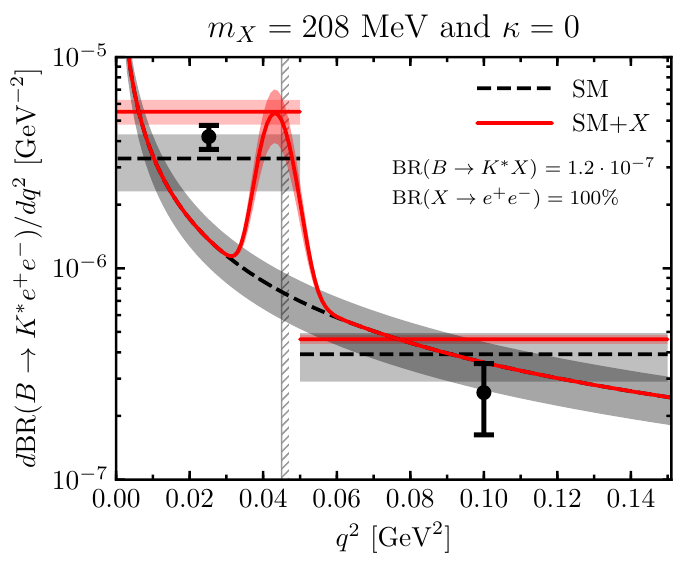
Figure 3 . The di(cid:11)erential branching ratio d BR( B ! K (cid:3) e + e (cid:0) ) =dq 2 in the SM (dashed black) and in the presence of a resonance with the best-(cid:12)t values for its mass and BR( B ! K (cid:3) X ) (solid red). We also show the binned predictions together with the LHCb measurements from ref. [19]. The vertical line indicates the lower boundary of the low- q 2 bin in the R K (cid:3) measurement. key prediction is therefore a peak in the di(cid:11)erential B ! K (cid:3) e + e (cid:0) rate at a q 2 close to the di-muon threshold. For a resonance that decays only to electrons ( y = 0 ; (cid:20) = 0), the 68 : 27% C.L. region for the mass is m 2 [203 ; 212] MeV. If instead the resonance has a X non-negligible decay mode into muons (like the dark photon) the 68 : 27% C.L. region is m 2 [203 ; 211] X